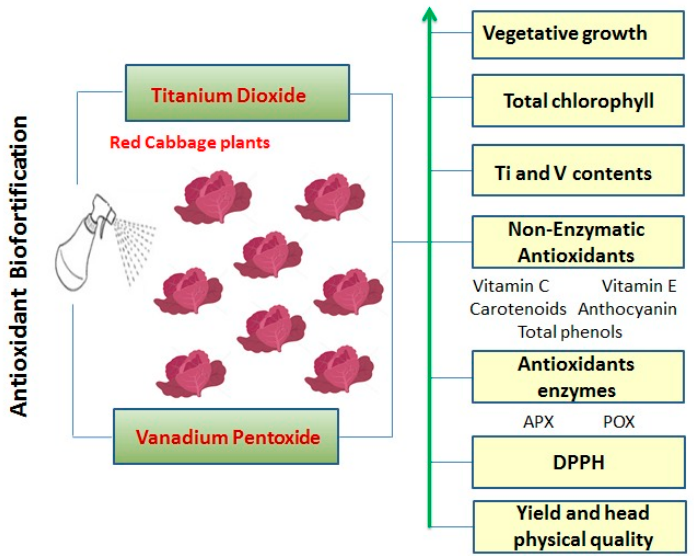
Figure 7. Simplified conclusion for the suggested effect of Ti and V application as a foliar spray on the growth and bioactive compounds of red cabbage plants grown under field conditions.